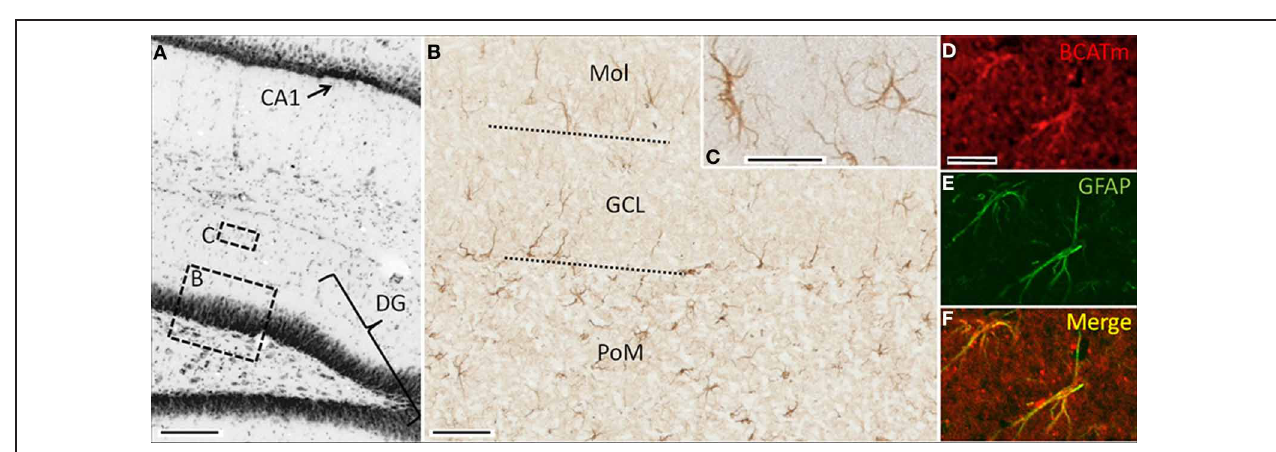
FIGURE 3 | Immunolocalization of BCATm in the hippocampal formation. (A) Nissl-stained coronal section showing portions of the dentate gyrus (DG) and field CA1. Regions similar to those enclosed by boxes B and C are shown at higher resolution in panels B and C . (B) Peroxidase-visualized immunolabel of BCATm in the dentate gyrus. Approximate boundaries of the granule cell layer (GCL) are shown by the dotted lines. (C) Higher resolution image of BCATm-immunolabeled